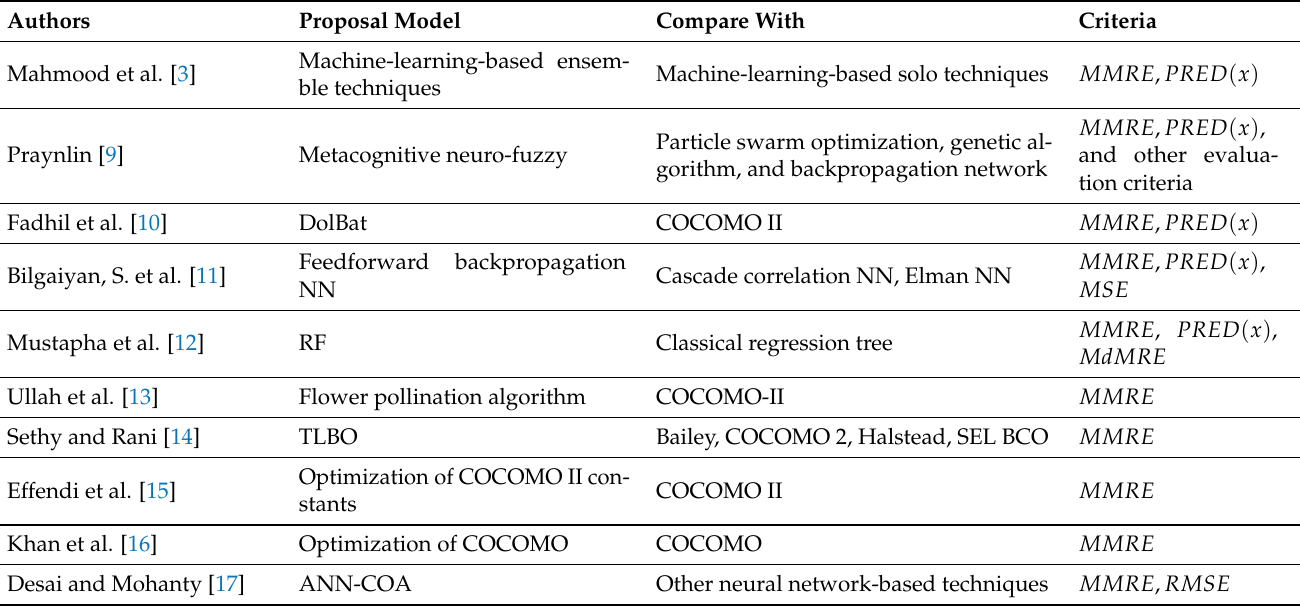
Table 1. Summary of reviewed related papers in recent years, where the MMRE was